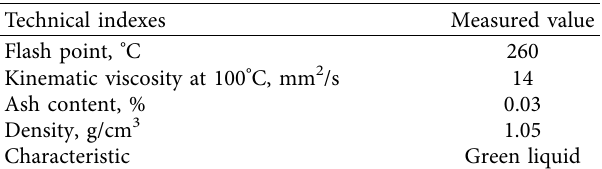
Table 4: Technical indexes of